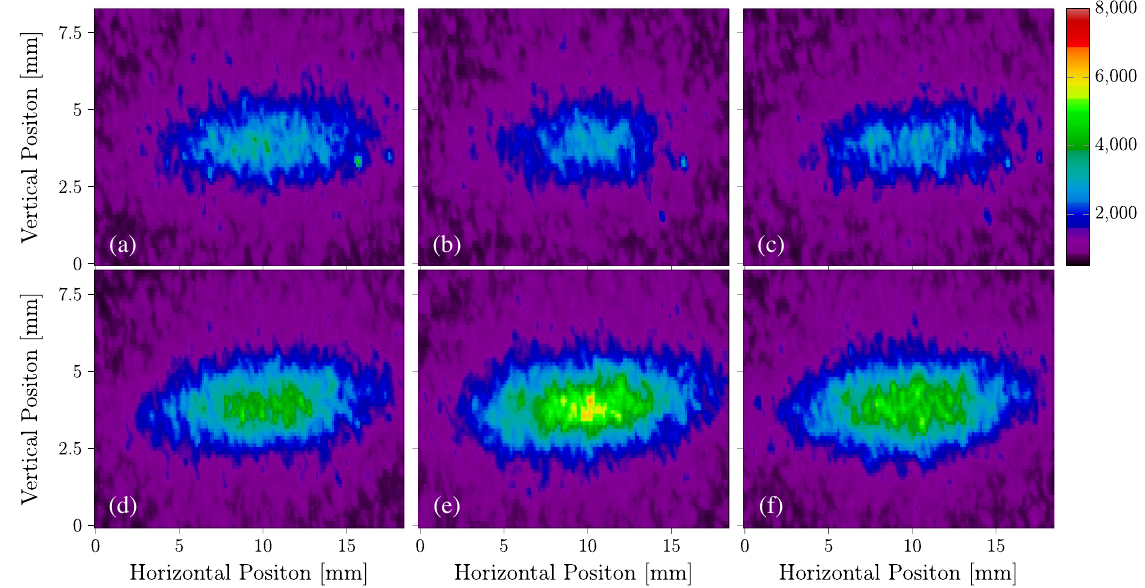
FIG. 11. Image with a glassy carbon target at 20° with respect to normal at the polarization angle of (a) 0°, (b) 30°, (c) 60°, (d) 90°, (e) 120°, and (f) 150°.